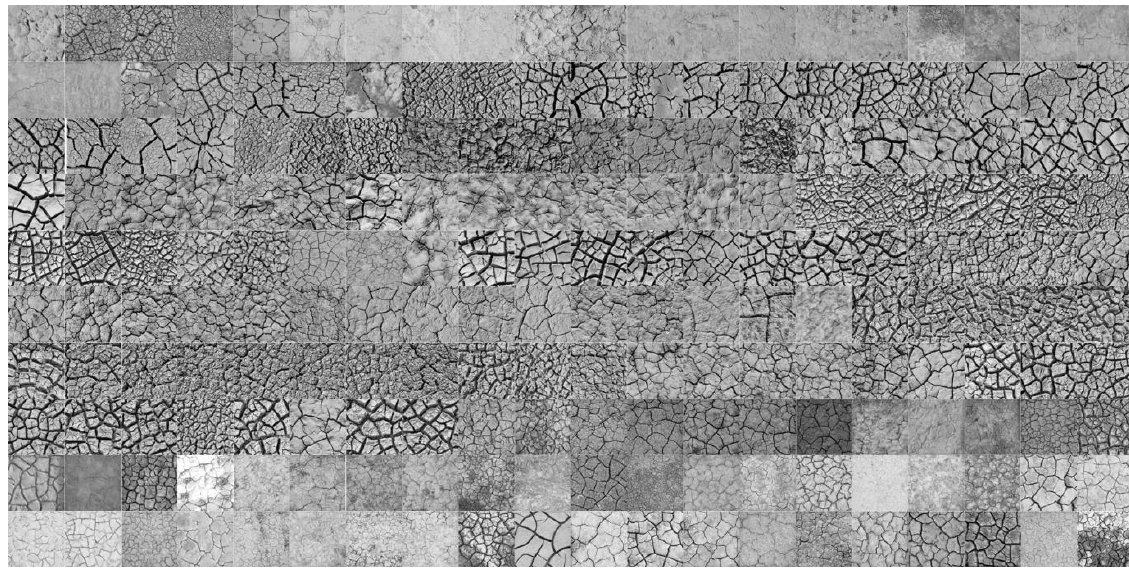
Figure 2. Grayscale images of cracked soil